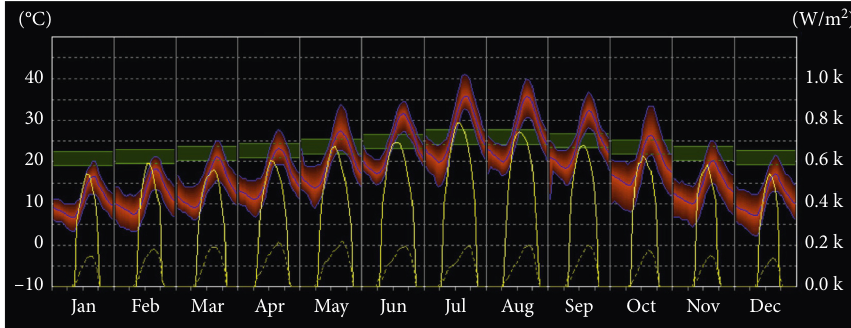
Figure 7: Graphs of monthly diurnal average temperatures, location Seville, Spain.